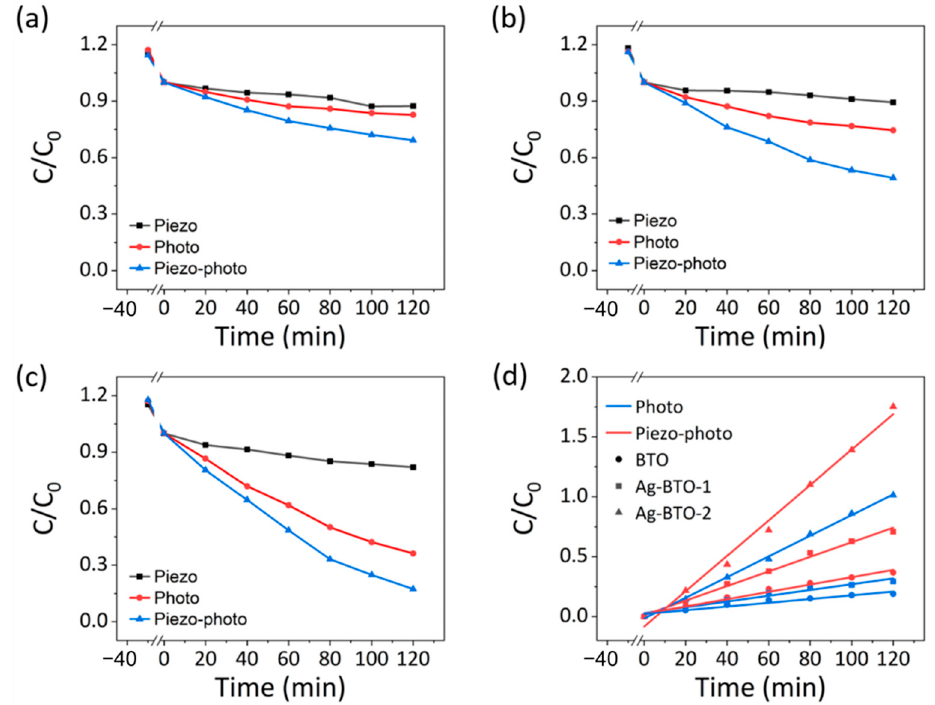
Figure 5. Catalytic performance comparison. ( a – c ) The piezocatalysis, photocatalysis, and piezo- photocatalysis of ( a ) BTO, ( b ) Ag-BTO-1, and ( c ) Ag-BTO-2. ( d ) The reaction kinetics.